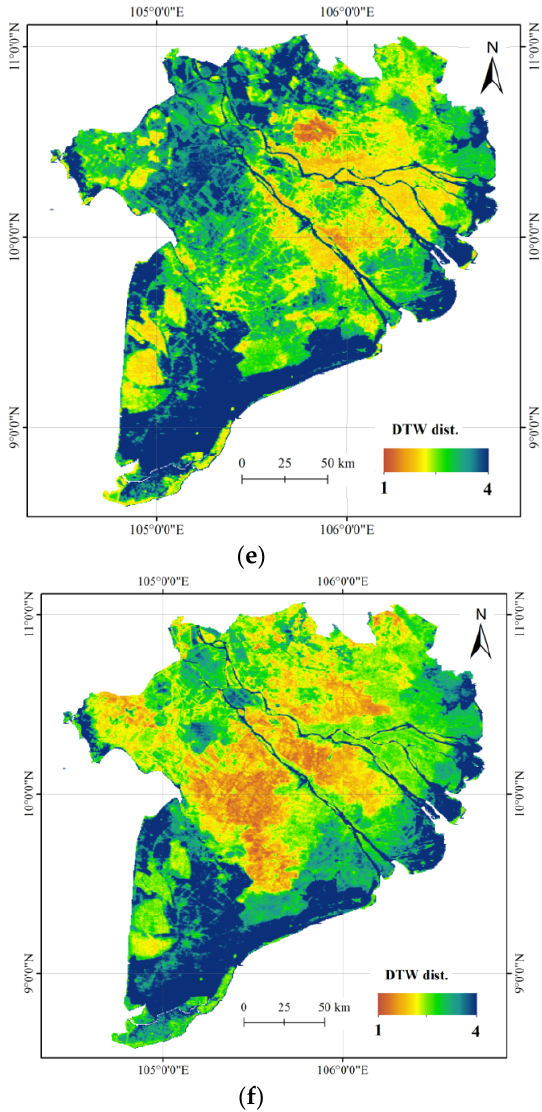
Figure 6. The results for the DTW distance: ( a ) The DTW distance of single rice cropping in the Mekong River Delta; ( b ) the DTW distance of double rice cropping I in the Mekong River Delta; ( c ) the DTW distance of double rice cropping II in the Mekong River Delta; ( d ) the DTW distance of triple rice cropping I in the Mekong River Delta; ( e ) the DTW distance of triple rice cropping II in the Mekong River Delta; ( f ) the DTW distance of triple rice cropping III in the Mekong River Delta.